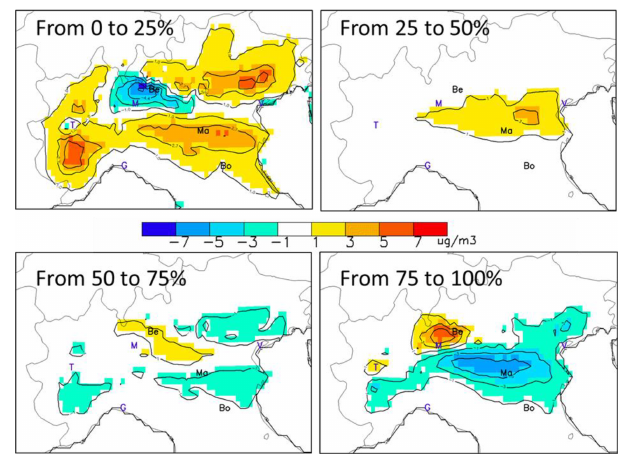
Figure 5. Yearly averaged chemical regimes obtained from a 25% emission reduction starting at different levels of emissions corre- sponding to α = 0, 25, 50 and 75. The maps represent the ( P NO P NH ) between the starting and ending levels (unit: µgm − 3 ) show- 3 ing the NO x - and NH 3 -sensitive areas in yellow/red and blue, re- spectively. The abbreviations Be, Ma and Bo indicate the location of Bergamo, Mantua and Bologna, respectively. Other cities are in- dicated by their first letter for convenience: Venice, Milan, Turin and